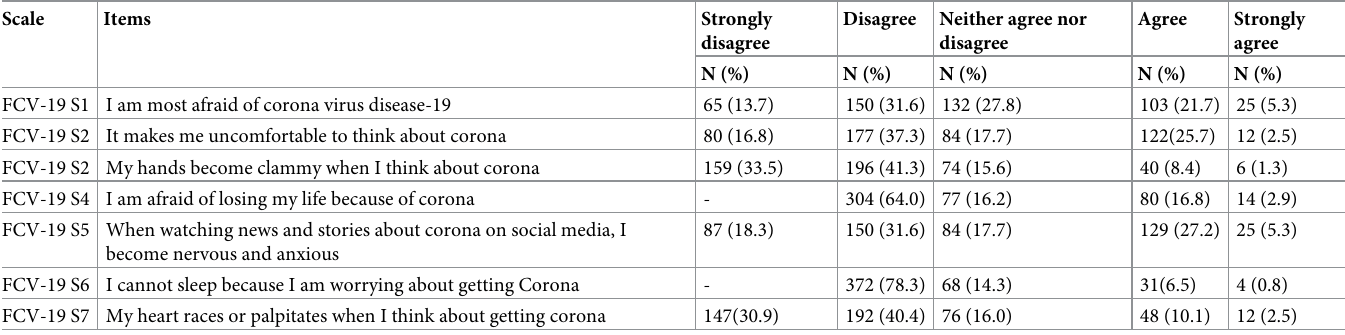
Table 2. Itemwise distribution of